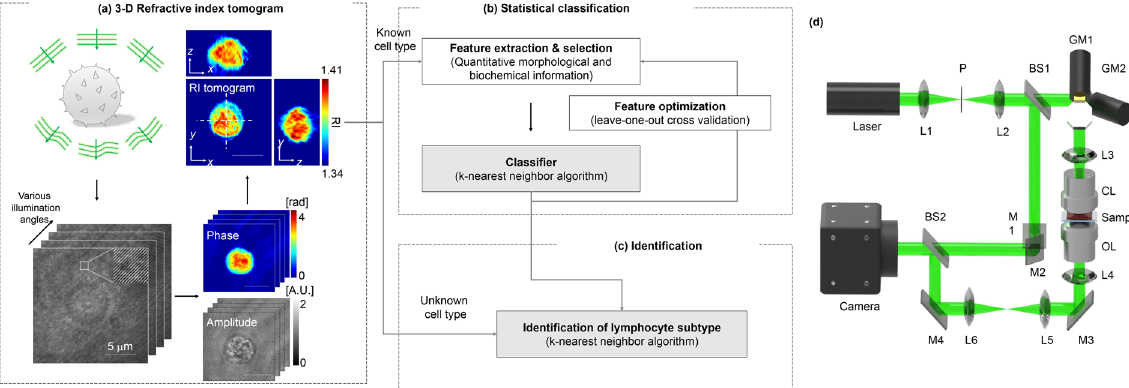
Figure 1. Schematic diagrams of the label-free identification of individual lymphocytes using optical diffraction tomography and machine learning. ( a ) Procedures for label-free measurement of 3-D RI tomograms of lymphocytes. Multiple holograms of a lymphocyte are measured by changing the angle of illumination. Optical field information with various incident angles was retrieved from the measured holograms, and then 3-D RI tomograms were reconstructed using an optical diffraction tomography algorithm. Scale bar, 5 μ m. ( b ) Training a statistical cell type classifier for identifying lymphocyte cell types using the k -NN algorithm. The multiple quantitative morphological and biochemical features of individual lymphocytes were combined to recognize and exploit the cell-type-specific fingerprints via supervise learning. ( c ) Identifying the cell types of newly observed individual lymphocytes with the established classifier. ( d ) Schematic of the experimental setup. A Mach-Zehnder interferometric microscope equipped with a 2-D scanning galvanomirror (GM) was used for measuring the holograms of individual lymphocytes. L1 − 6, lenses; P, pinhole; BS1 − 2, beam splitters; M1 − 4, mirrors; CL, condenser lens; OL, objective